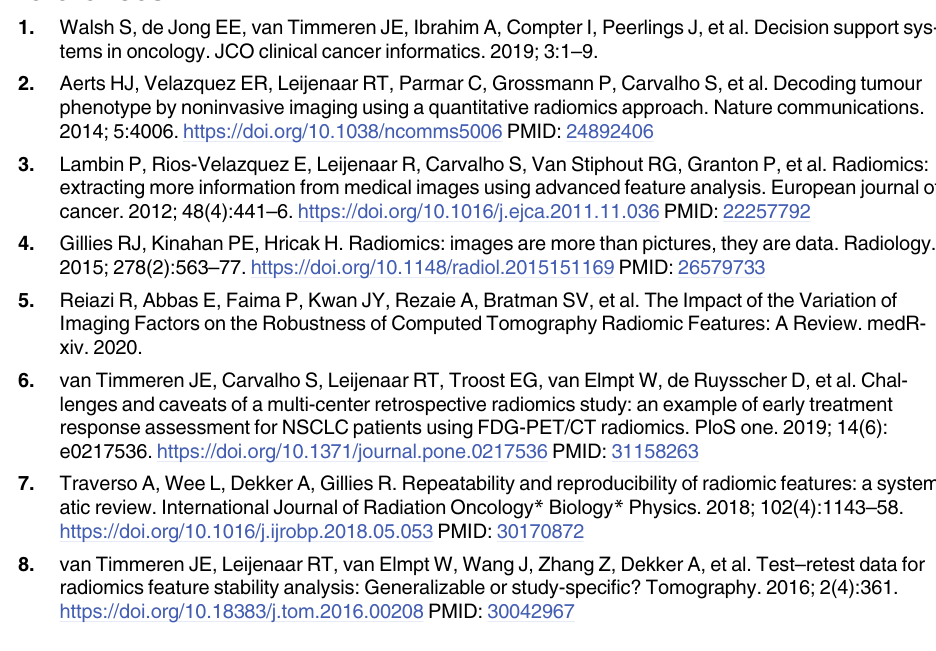
S1 Table. The agreements and disagreements in the scanner models and scanning parame- ters in the pairwise